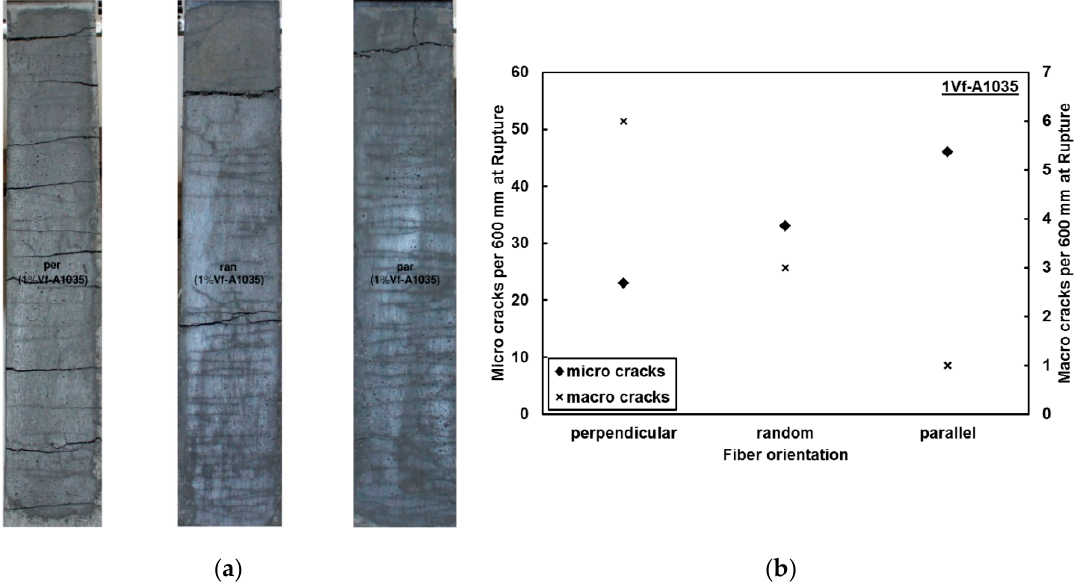
Figure 21. Failure of specimens w.r.t. fiber orientation: ( a ) Failure patterns; ( b ) Number of cracks.